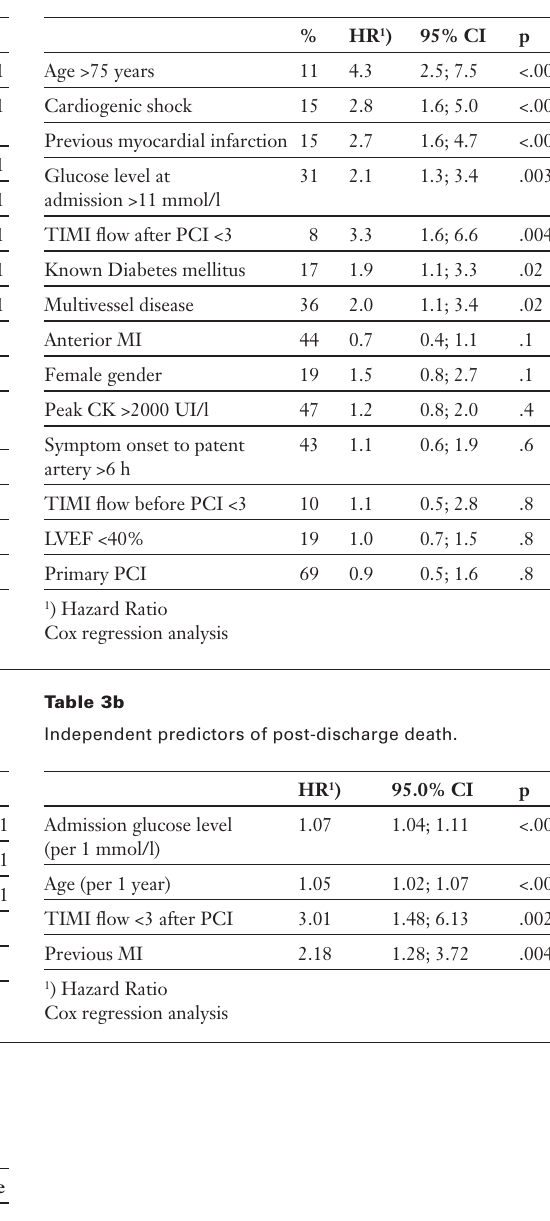
Non-adjusted risk of in-hospital death (N = 978). Non-adjusted risk of post-discharge death (N = 978).